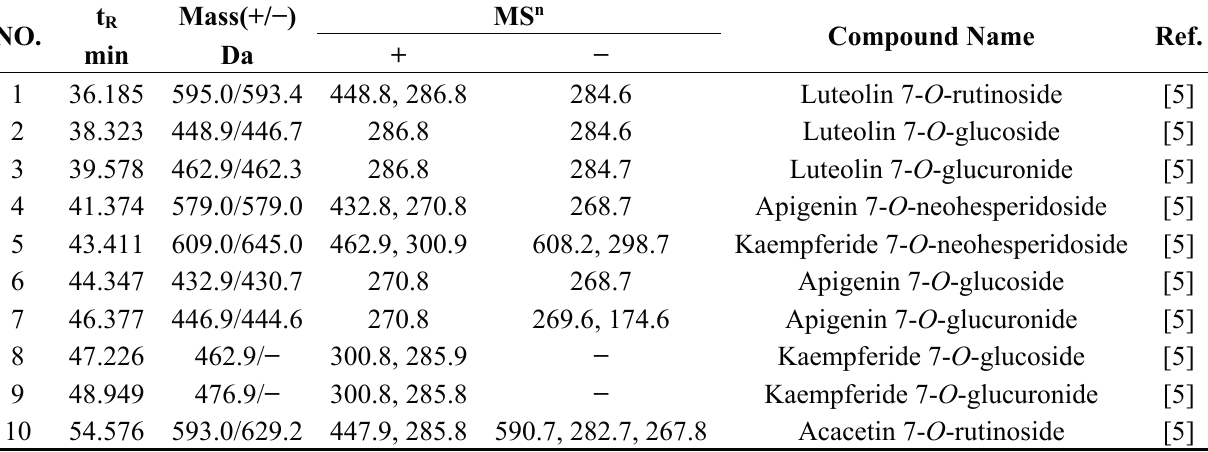
Figure 3. Ten flavonoid glycosides in Chrysanthemum morifolium Ramat by HPLC-MS n analysis. Table 1. HPLC results of extracts from Chrysanthemum morifolium